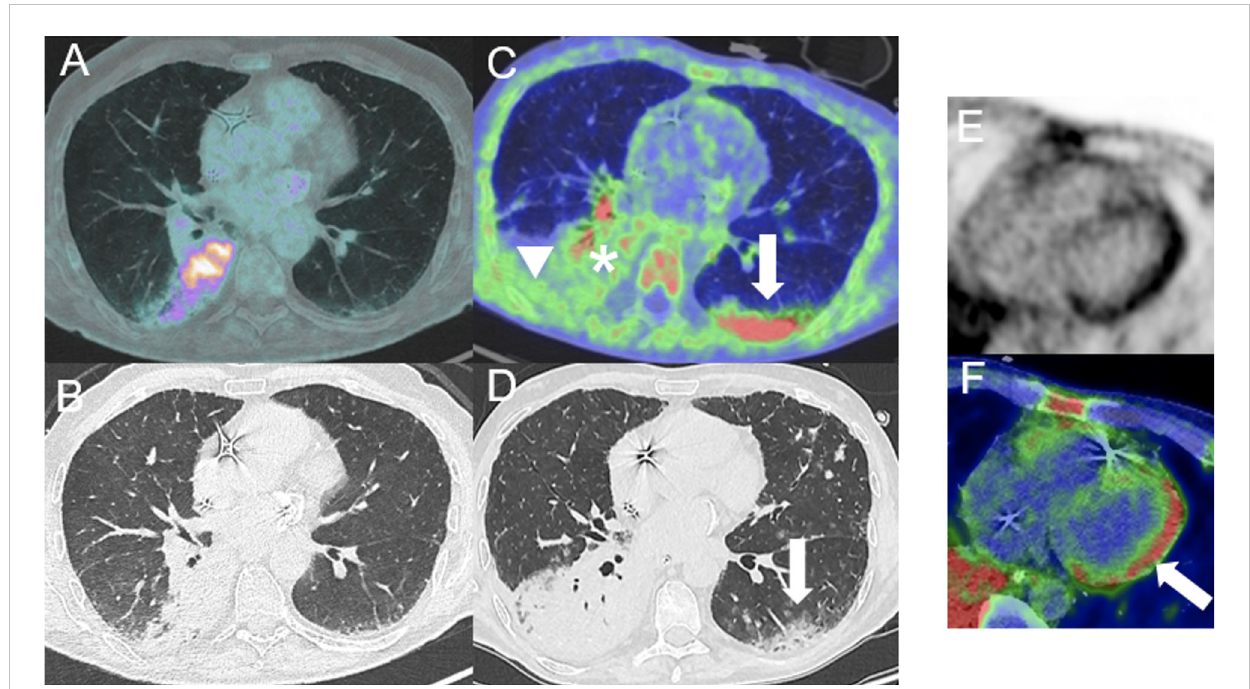
FIGURE 5 Immune-related myocarditis in a 61-year-old male with mucinous lung adenocarcinoma in right lower lobe [cT4 (>7cm) cN0 cM0] initially treated with carboplatin, vinorelbine and radiation therapy followed by consolidation treatment with durvalumab (anti-PD-L1). Baseline (before ICI) fused axial 18 FDG PET/CT image (A) and corresponding axial CT image (B) . After 2 cycles of durvalumab, the patient experienced severe dyspnea, atrial fi brillation leading to cardiogenic shock with clinical suspicion of ICI-related myocarditis. 68 Ga-DOTATOC-PET/CT showed necrotic areas in the lung cancer [asterisk, (C) ] with presence of peripheral in fl ammatory/infectious uptake [arrowhead, (C) ] and newly appeared subpleural alveolar consolidations in the left lower lobe compatible with an organizing pneumonia [arrow, ( C, D) ]. 68 Ga-DOTATOC-PET/CT showed diffuse myocardial uptake in the left ventricle (LV) [ (E, F) ], with an increased uptake ratio of 2.6 (SUVpeak LV myocardium /SUVmean LV cavity ) suggestive of myocarditis [arrow, fused axial PET/CT image (F)